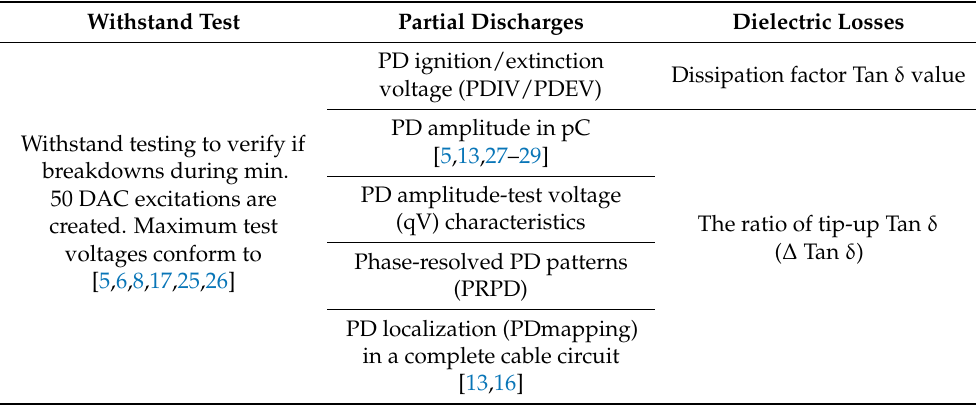
Table 5. Testing and diagnostic parameters for newly installed and service-aged long-length power cables